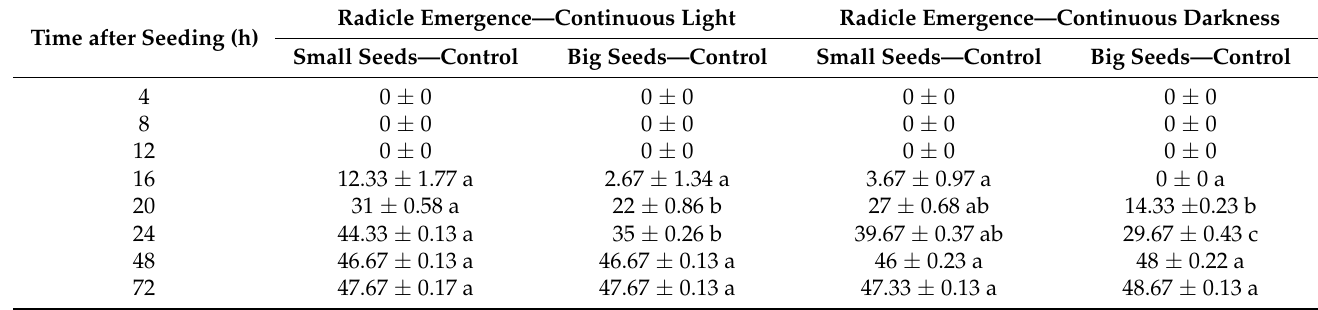
Table 2. Effect of seed size of winter wheat and light conditions (continuous light and darkness) on the kinetics (expressed as time in hours) of radicle emergence (complete germination) during germination of control samples (without EMF treatment).